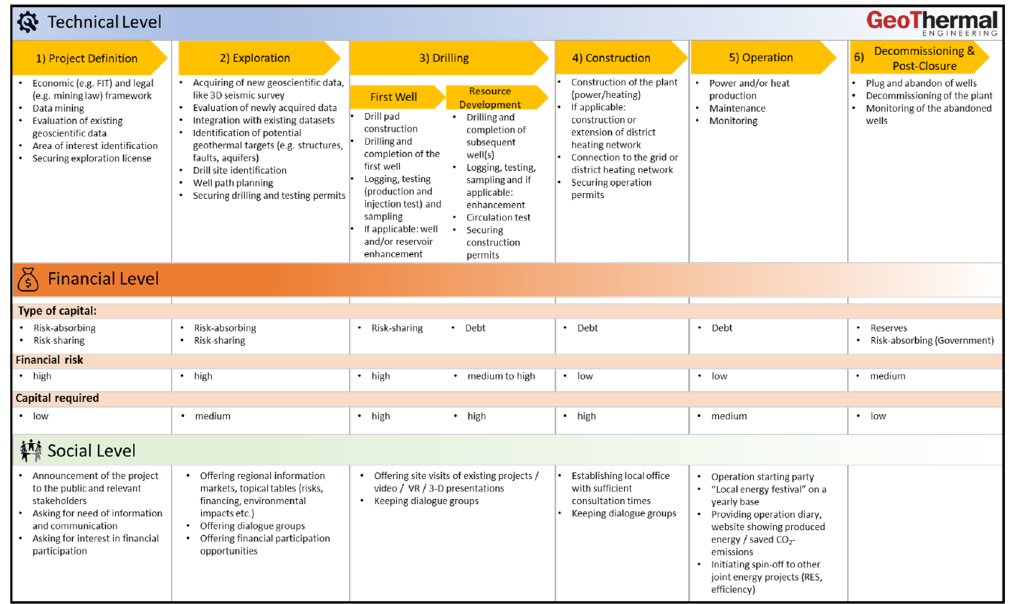
Figure 9. Integration of technical, financial and social project levels [44].